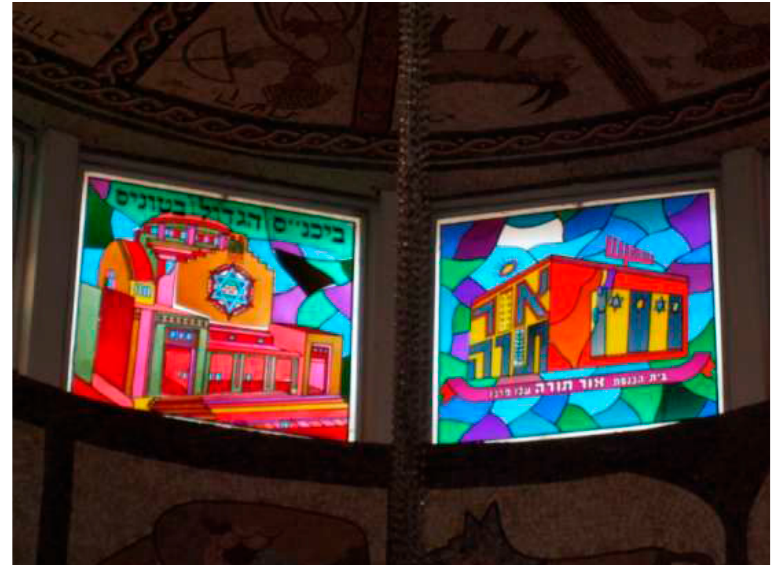
Figure 4. Part of the stained-glass window at the Or Torah Synagogue, Acre (photo: the author,